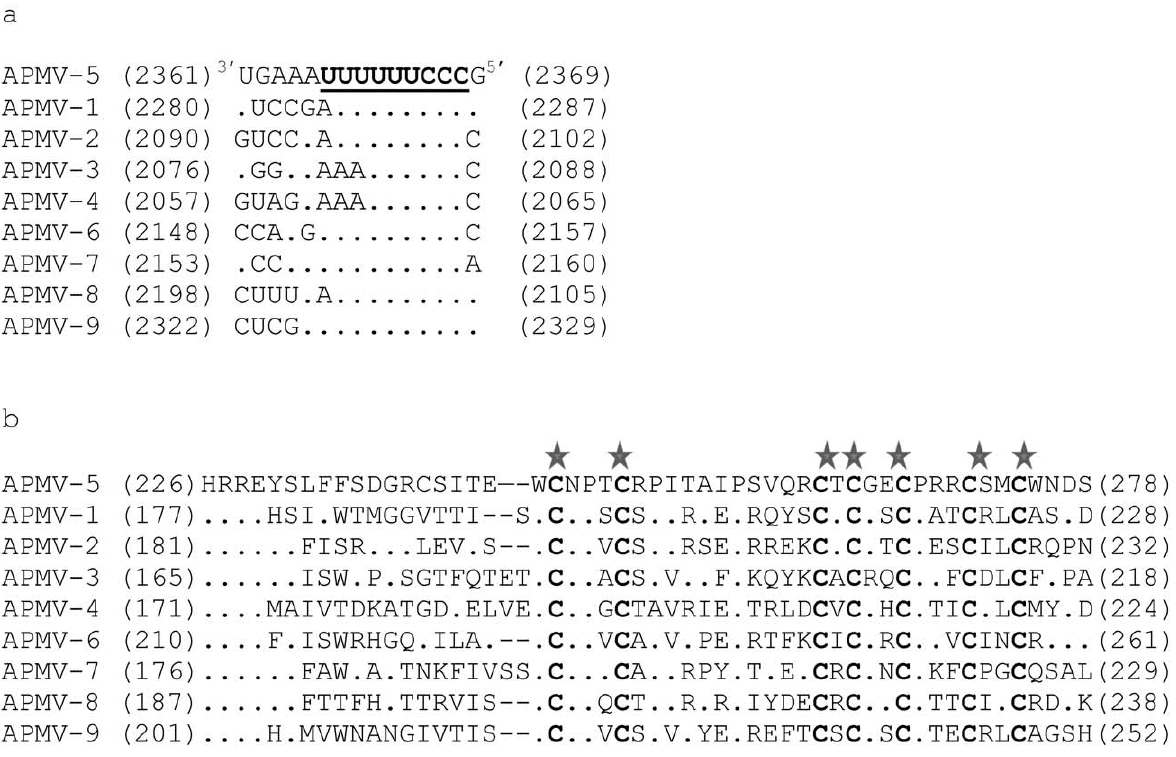
Figure 3. Sequence alignments of P gene editing site and C-terminal region of V protein of all APMV prototype strains. Sequence alignments of (a) the RNA editing site in the P gene (shown in negative-sense) and (b) the C-terminal domain of the V protein of APMV-5 versus prototype viruses of the other eight APMV serotypes. The editing site is underlined. Dots indicate nucleotides identical to those of APMV-5. The conserved cysteine residues in V protein are bolded and marked by stars. The numbers in the parenthesis indicate the corresponding nucleotide position in the complete genome (a) and amino acid position of V gene (b). doi:10.1371/journal.pone.0009269.g003 PLoS ONE |